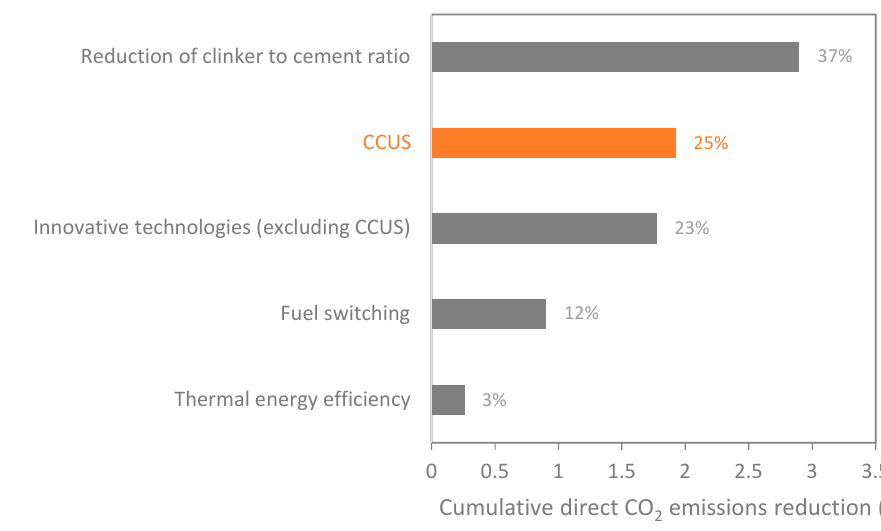
Figure 2. Global cumulative CO 2 emissions reductions by 2050 (2DS vs. RTS) (adapted from [3]).